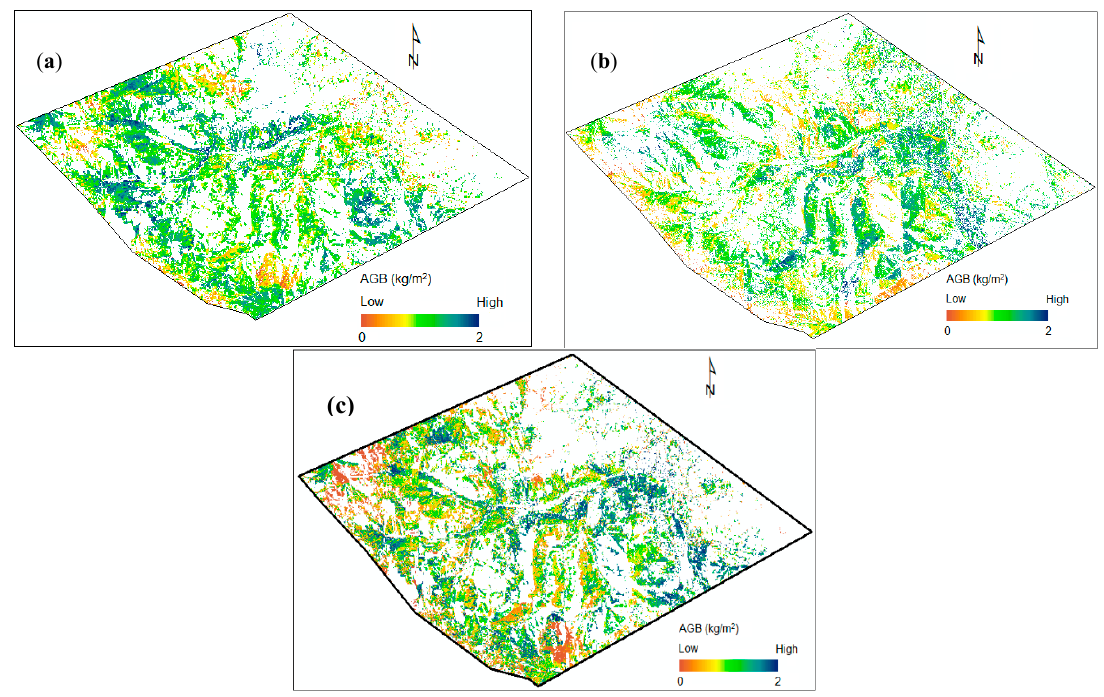
Figure 6. AGB variations in February 2016, derived using ( a ) Landsat 8, ( b ) Sentinel 2, and ( c ) WorldView-2 remote sensing datasets.